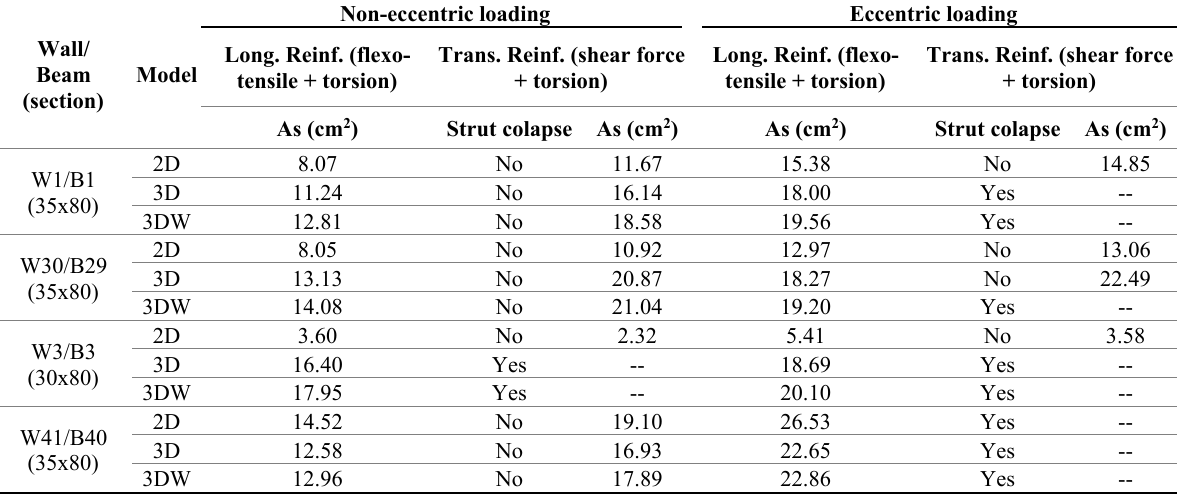
Table 12 – Support beam design for vertical loading with and without